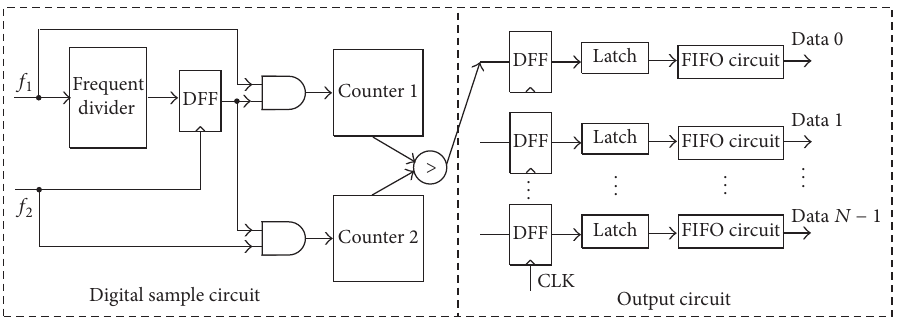
Figure 7: Digital sample circuit and output circuit.